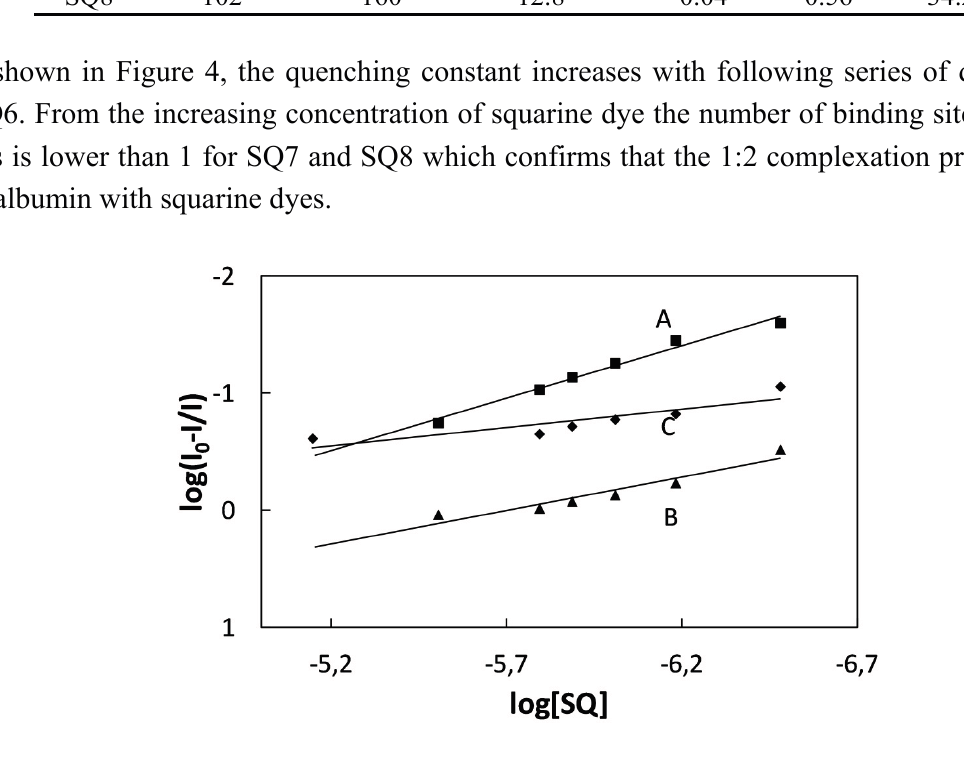
Figure 4. Modified Stern-Volmer plots of binding parameters BSA with squarine dyes: SQ6 (A), SQ7 (B), SQ8